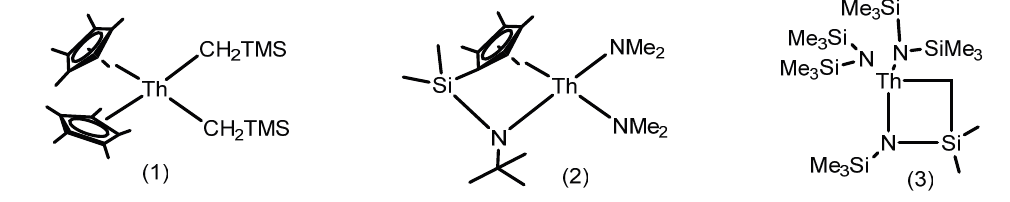
Figure 1. Thorium complexes 1 – 3 used as pre-catalysts in the hydroalkoxylation/cyclization of alkynyl